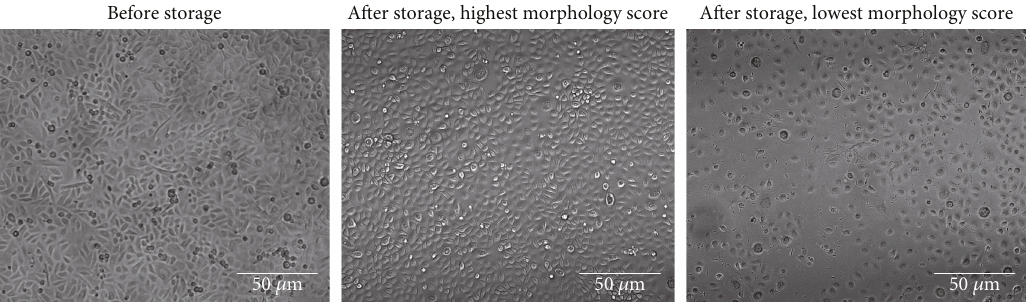
Figure 2: Typical light microscopy images illustrating morphology of cells before and after storage for 11 days. The cells were primary epidermal cells stored at passage